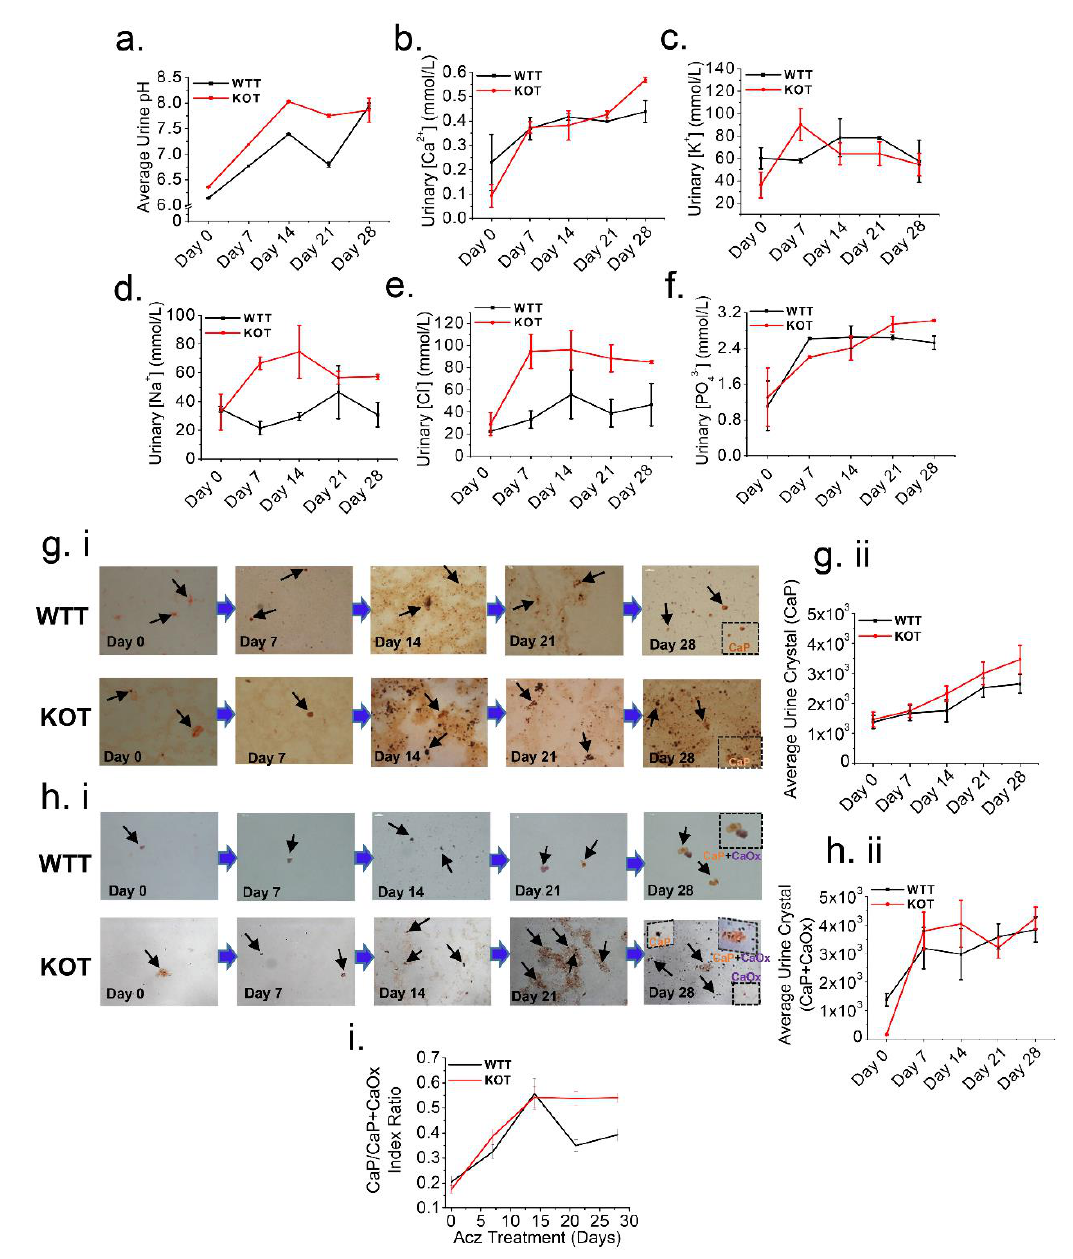
Figure 4. Higher luminal pH induced by Acz treatment induces CaP crystals formation. Representative line graphs of ( a ) Urine pH, urine electrolyte excretion levels ( b ) Ca 2+ , ( c ) K + , ( d ) Na + , ( e ) Cl − and ( f ) PO 43 − , collected on day 0, 7, 14, 21 and 28 of the treatment periods immediately after 24 h urine collection. ( a , b ) and ( d–f ) Urinary pH, Ca 2+ , Na + , Cl − and PO 43− clearance progressively increased throughout the treatment period, particularly for the KOT group. ( c ) Urine K + on the other hand showed a reduction in clearance for both the untreated and treated groups throughout the treatment period. All urine measurements were normalized by creatinine. ( gi ) Alizarin Red (AR) pH 4.3 (stains CaP crystals) and ( hi ) pH 6.8 (stains both CaOx and CaP+CaOx crystals) to differentially visualize calcium crystals present in the urine. Black arrows show urine crystals (CaP and CaP+CaOx). ( gii , hii ) representative line graphs for both WTT and KOT groups showing progressive increase in CaP and CaP+CaOx urine crystals respectively following Acz treatment. ( i ) CaP to CaP/CaOx index ratios throughout Acz treatment period which compared WTT and KOT mice groups were quantitated into means ± SEM. Experiments performed n = 4 times.